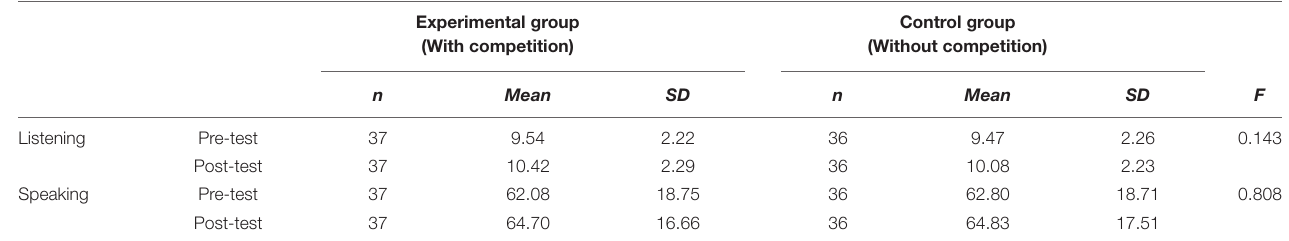
Experimental group (With competition)